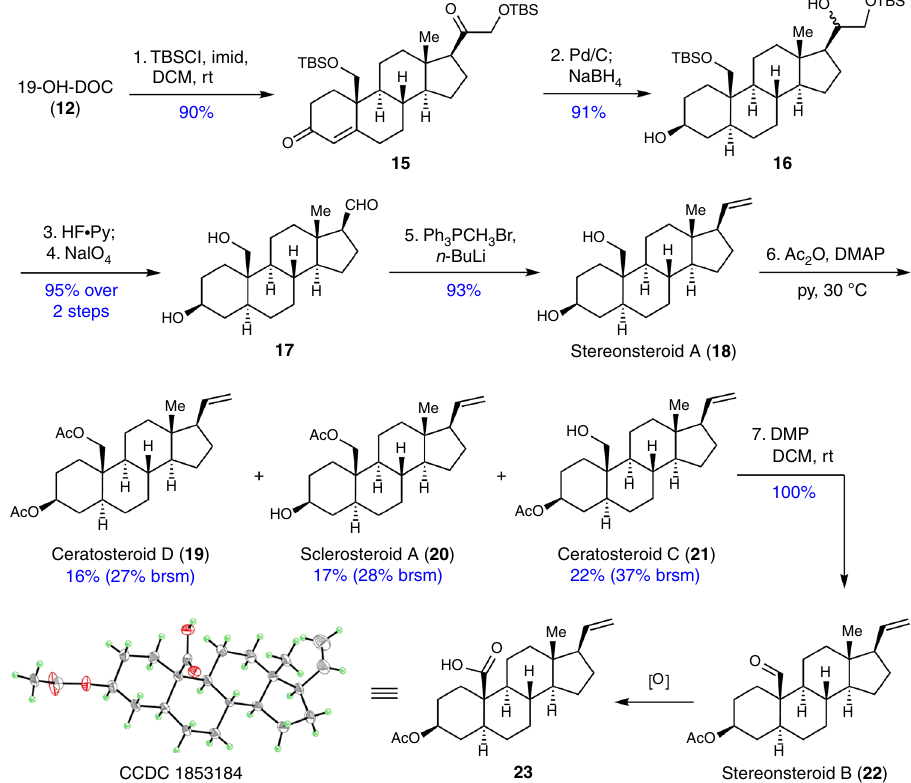
Fig. 4 Uni fi ed synthesis of the stereonsteroid family. Five stereonsteroid family members including sclerosteroid A, stereonsteroid A and B, ceratosteroid C and D were synthesized from the common intermediate 19-OH-DOC in 5 to 7